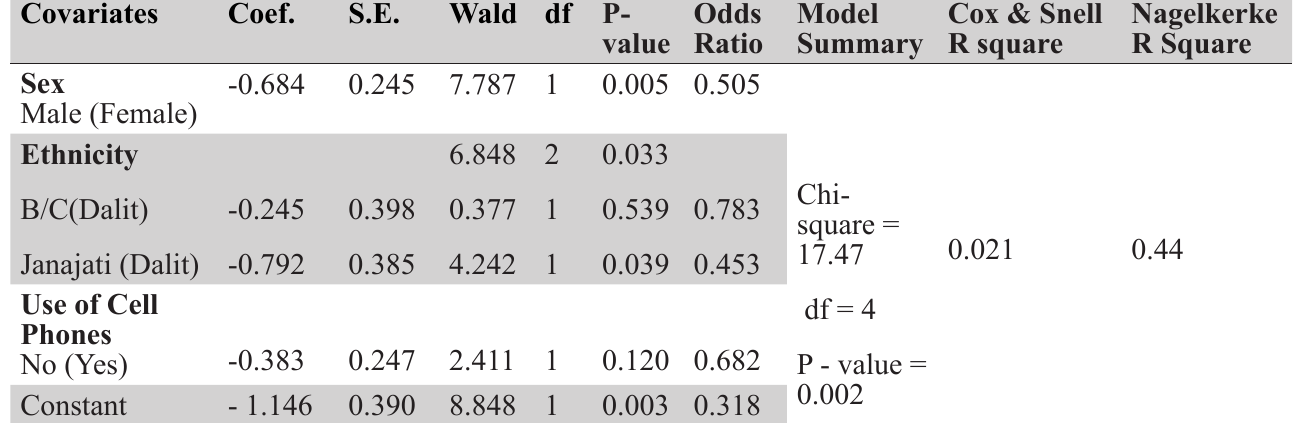
Table 5: Model summary of associative factors of refractive error. Covariates